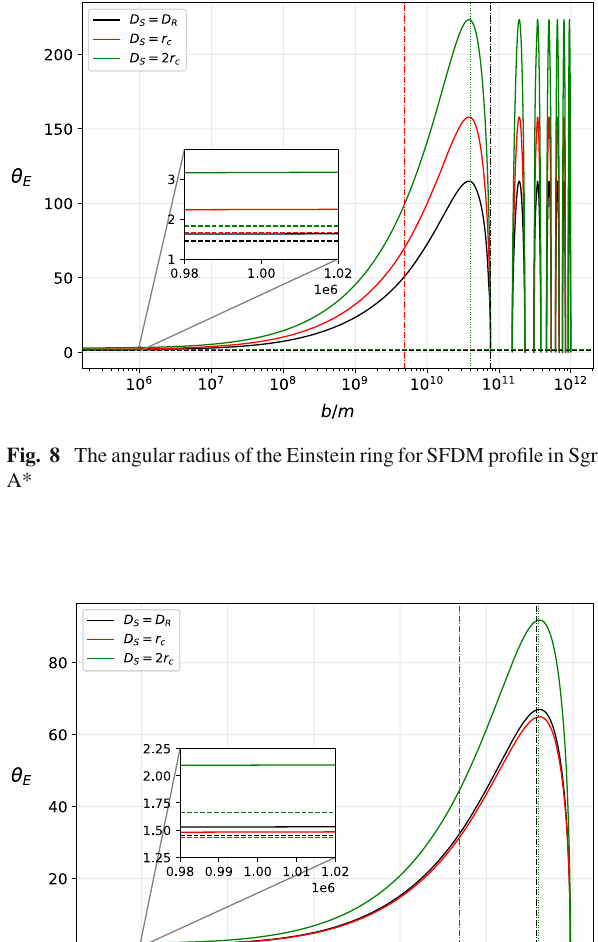
of the curve arises near b / m = D R , then a steep decrease in radius is seen. We see that the deviation went back to the Schwarzschild case near the core radius. For any b / m > r c